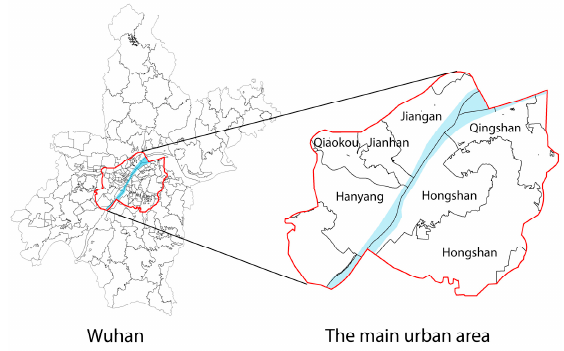
Figure 1. Location of the study area in Wuhan.